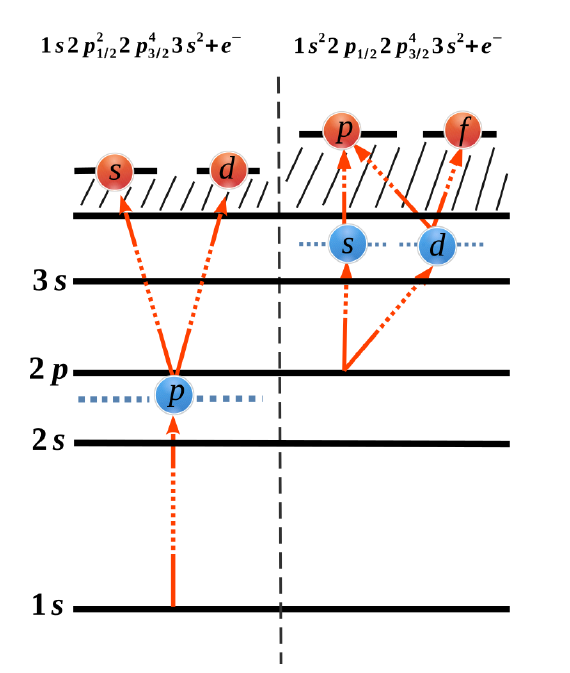
Figure 1. Schematic diagram of possible electric dipole ionization pathways for two-photon ionization of a 1 s ( left ) and 2 p 1 / 2 ( right ) electrons of neutral magnesium. The possible electric dipole ionization pathways in the single-active-electron picture are represented by red arrows. At the nonlinear Cooper minimum, the ionization pathways with highest angular momentum (right-most pathways) have zero contribution to the process. This has a significant impact upon all physical observables associated with the